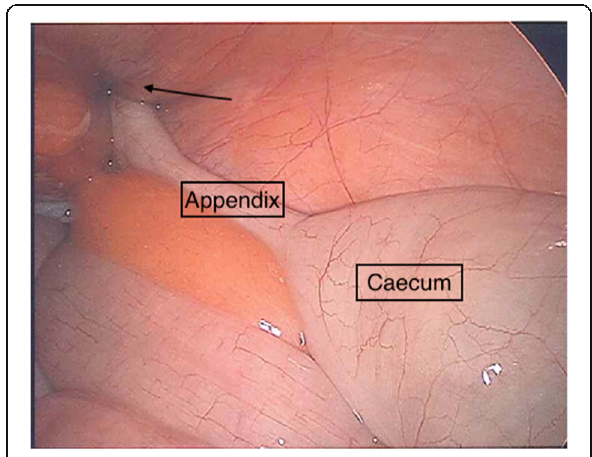
Fig. 2 Laparoscopic view of the appendix traveling through the femoral canal